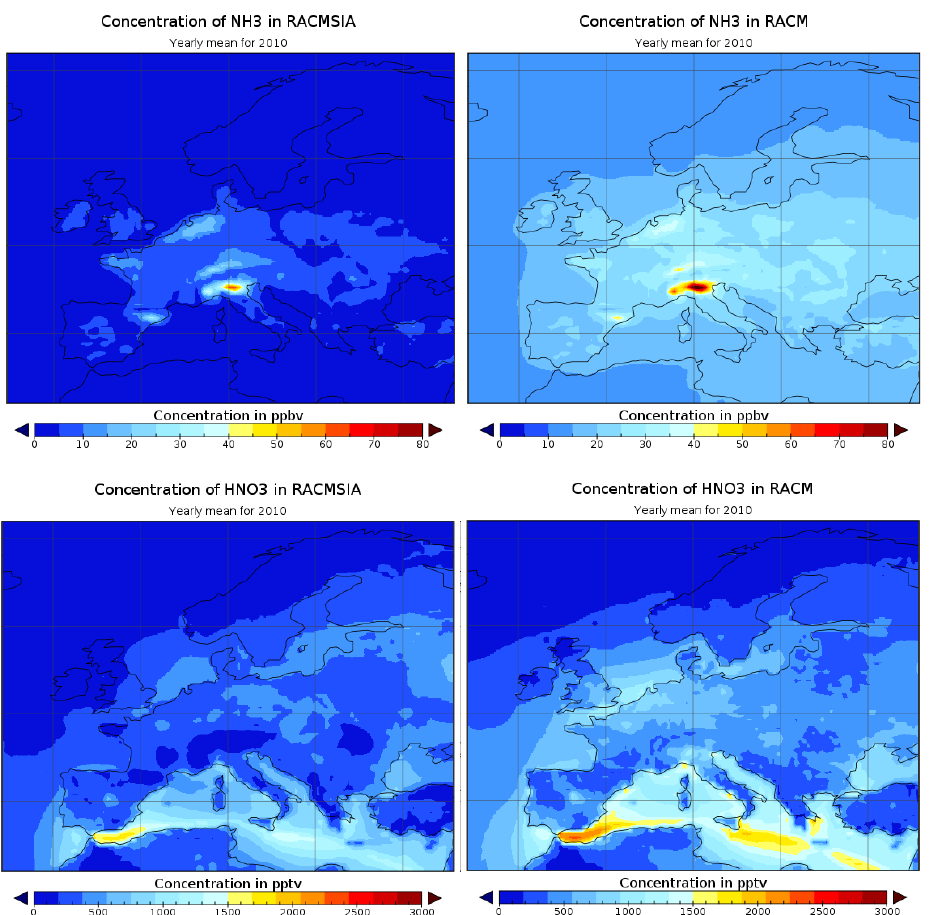
Figure 11. Maps of regional annual mean concentrations of NH 3 in ppbv (top panels) and HNO 3 in pptv (bottom panels) for both simulations: RACMSIA (left side) and RACM (right side).